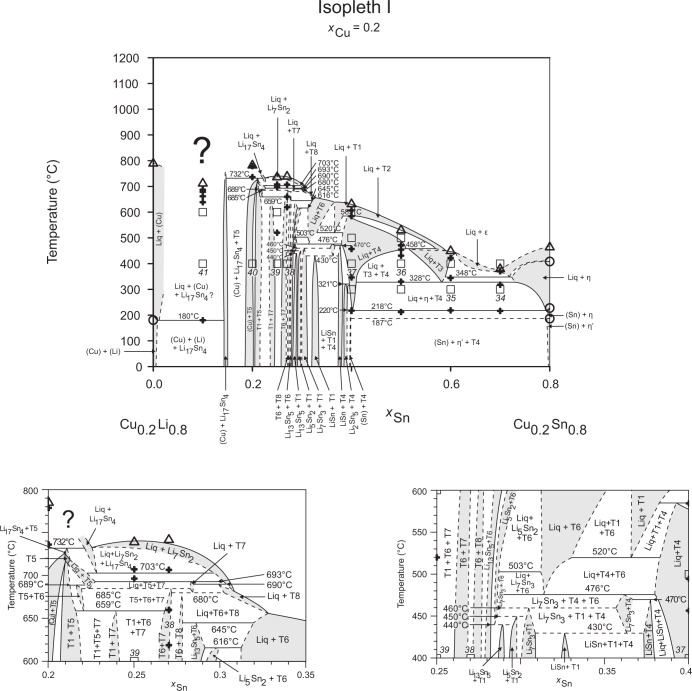
Isopleth I including sections from xSn = 0.20–0.35 / T = 600–800°C and xSn = 0.25–0.40 / T = 400–600°C.